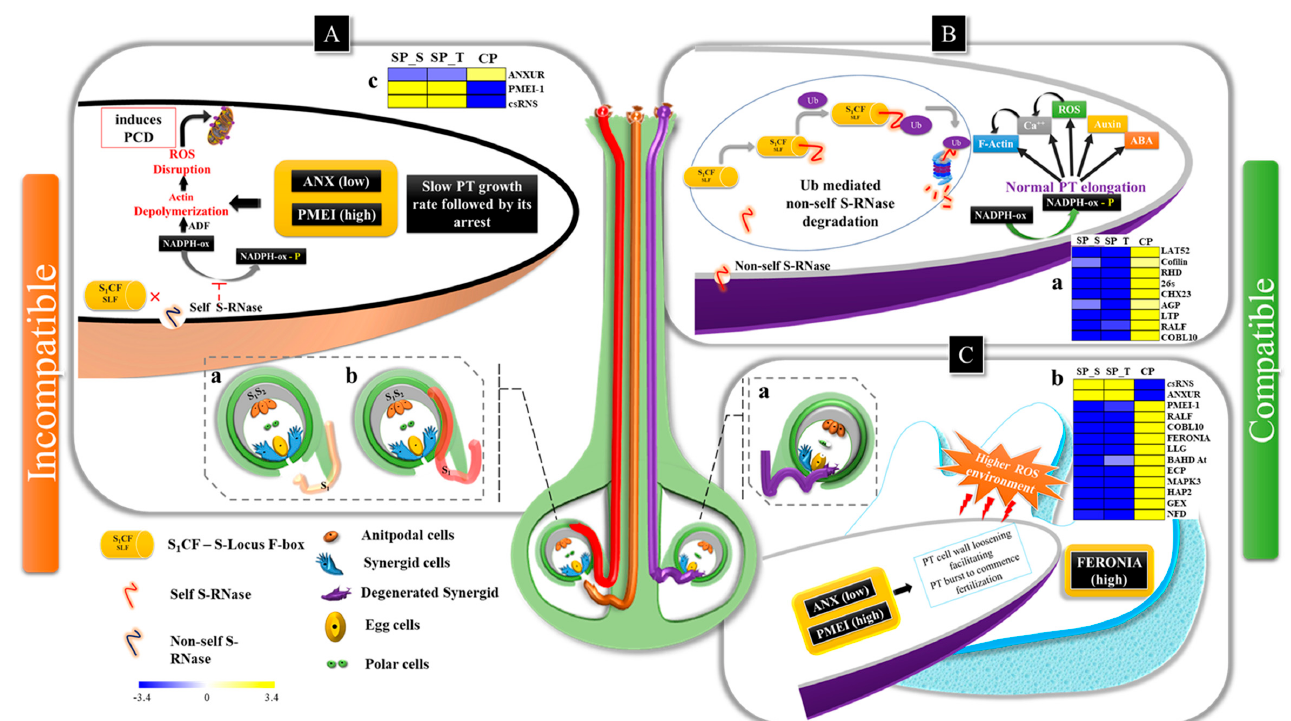
Figure 8. Summarized illustration representing self-incompatibility and cross-compatibility with tissue specific expression. The PT elongation within self and cross-pollinated pistil [Self PT: deviated (red) and ceased (brown), cross PT fertilization (purple)]. ( A ) Ceased ( a ) and deviated pollen tubes ( b ) representing incompatible interactions in style; ( c ) Heat map showing tissue specific qPCR expression of ANXUR-rlk, PMEI and csRNS in style revealing upregulated expression (yellow) of PMEI and csRNS in both SP coupled with downregulated expression (blue) of ANXUR-rlk; The self S-RNase (csRNS) in SP style inhibits phosphorylation of NADPH-ox, resultantly inducing programmed cell death (PCD) via depolymerization of actin cytoskeleton [44] ( B ) Normal PT elongation in style in CP as non-self S-RNase undergoes ubiquitin mediated protein degradation[10], ( a ) qPCR expression pattern showing up-regulated expression of genes involved in normal PT elongation in CP style. ( C ) Cross PT growth arrest followed by its burst within synergids commencing fertilization ( a ); qPCR expression pattern ( b ) of PT-ovular guidance and fertilization related genes exhibiting significantly up-regulated expression in CP ovaries. The lower expression of ANX coupled with higher expression of PMEI as observed in SP_style and CP_ovary suggests their putative role in inhibiting self-PT growth in SP style leading to SI and cross-PT inhibition in CP ovary to facilitate PT burst during fertilization. The yellow-blue scale represents fold change obtained in tissue specific relative expression analysis.